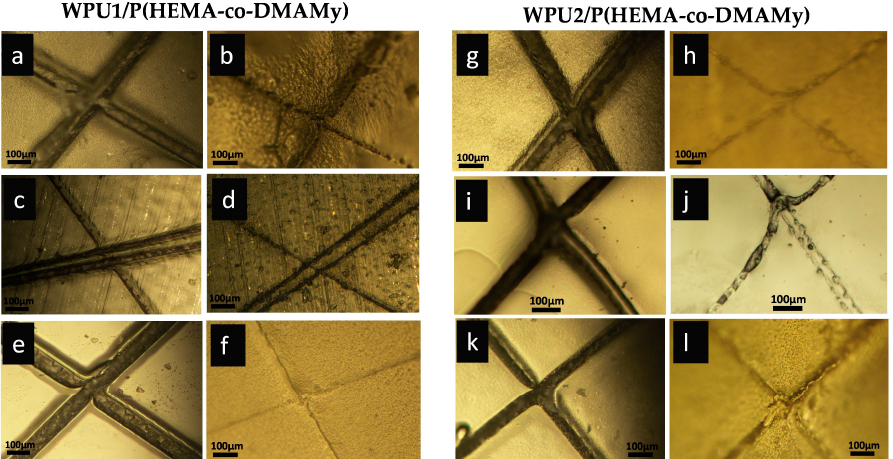
Figure 8. Optical microscopy photographs of ( a , b ) WPU1/20P(HEMA-co-DMAM20); ( c , d ) WPU1/20P(HEMA-co-DMAM50); ( e , f ) WPU1/20P(HEMA-co-DMAM80) and ( g,h ) WPU2/10P(HEMA-co-DMAM20); ( i,j ) WPU2/10P(HEMA-co-DMAM50); ( k , l ) WPU2/10P(HEMA- co-DMAM80) specimens: images under damage ( a , c , e , g , i , k ) and healed ( b , d , f , h , j , l ) samples. Scale bars indicate 100 μ